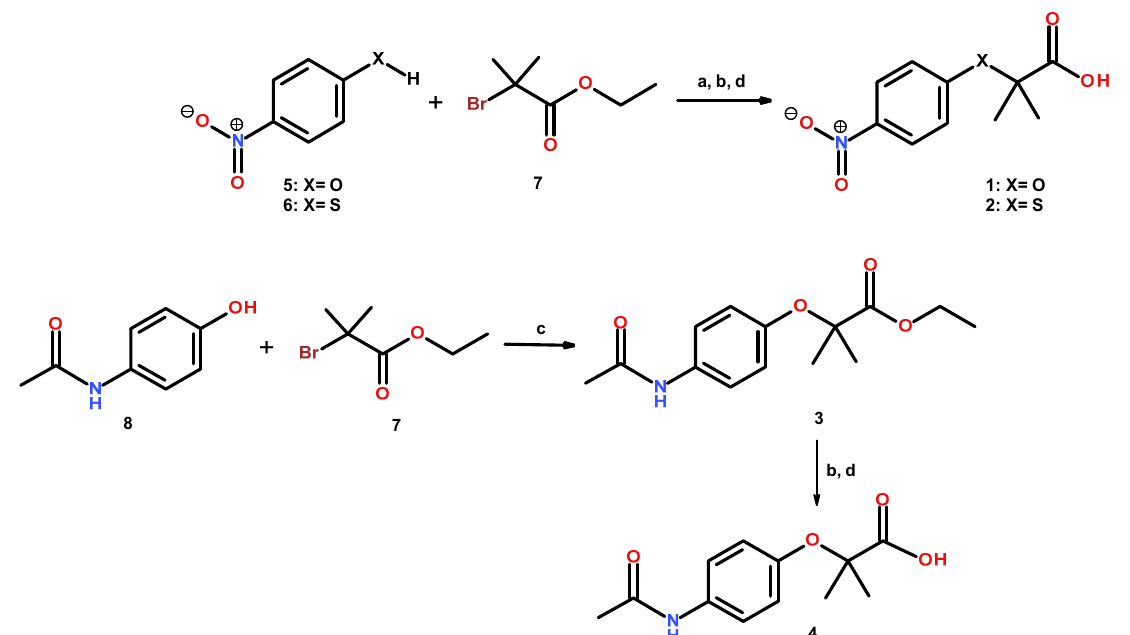
Figure 2. Synthesis of compounds 1 – 4 . (a) K 2 CO 3 , CH 3 CN, reflux; (b) LiOH, THF/MeOH/H 2 O; (c) K 2 CO 3 , DMSO, 80 °C; (d) HCl (10% v / v ).